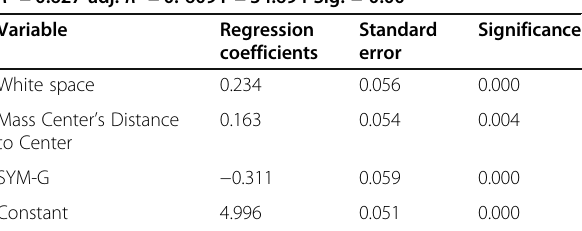
Table 1 Linear regression model predicting the paintings ’ visual order